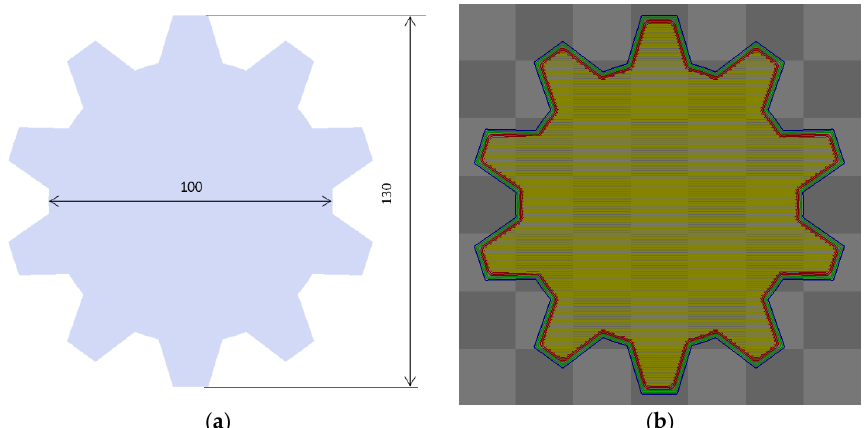
Table 3. Printing fit measurement data of CFRF